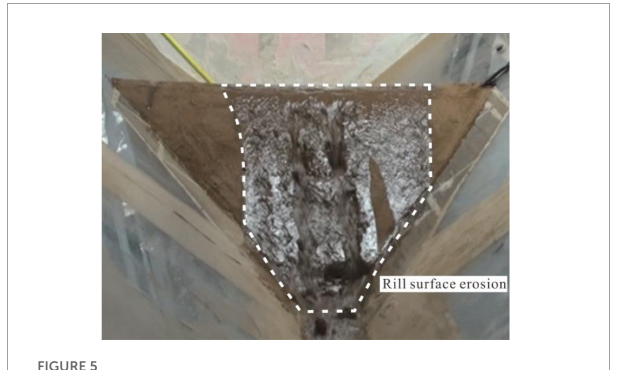
FIGURE5 Rill surface erosion.